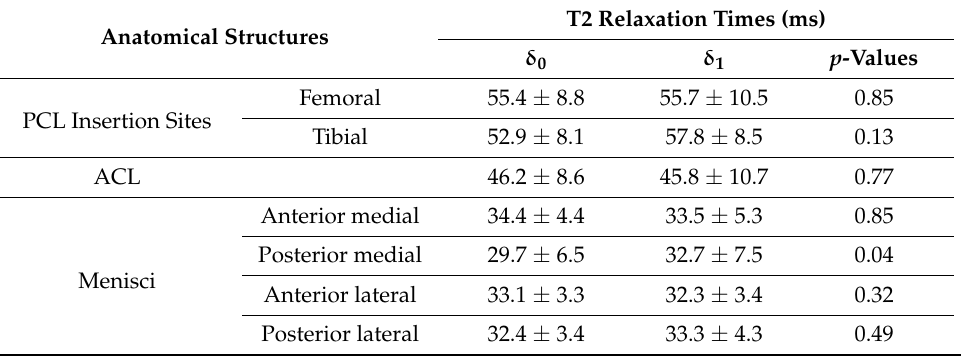
Table 3. T2 relaxation times of other intra-articular structures in response to loading. T2 relaxation times are indicated for the osseous insertion sites of the posterior cruciate ligaments (PCL), the anterior cruciate ligaments (ACL), and the anterior and posterior horns of the medial and lateral meniscus, in both the unloaded ( δ 0 ) and loaded ( δ 1 ) configurations. Mean ± standard deviations [ms]. Wilcoxon signed rank test was used to determine if configurations were significantly